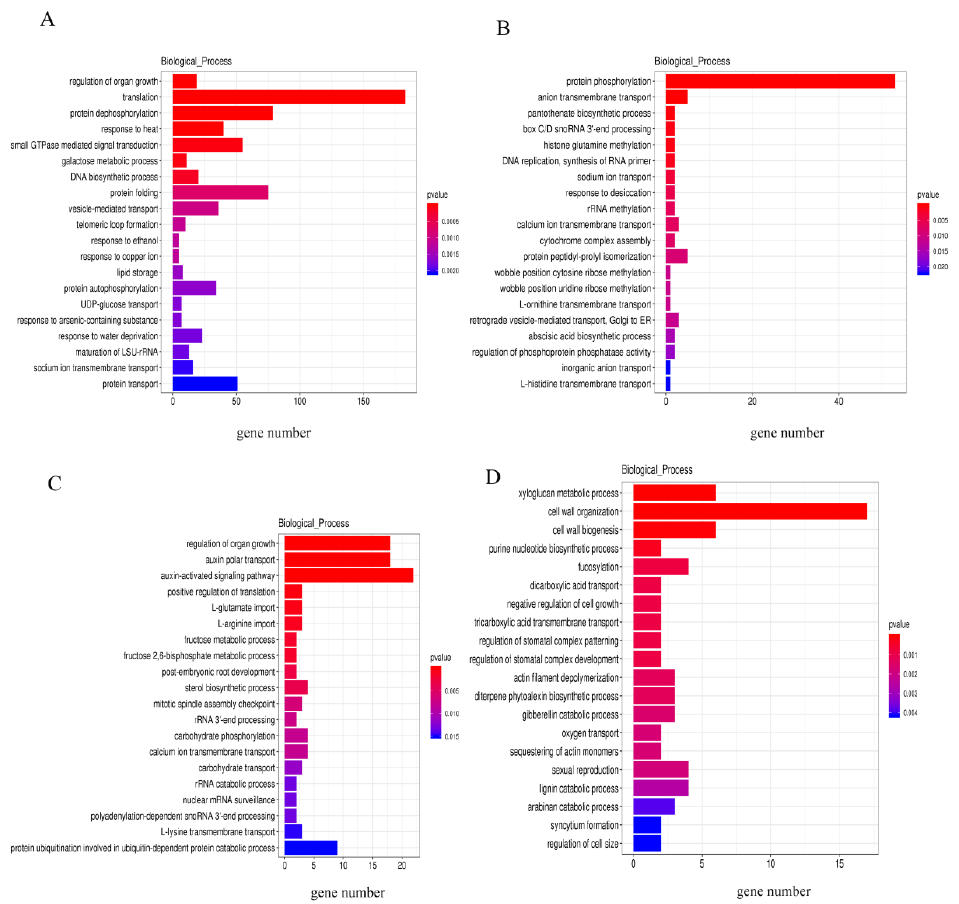
Figure 6. GO enrichment analysis of genes targeted by the DE lncRNAs. ( A ) Biological process terms enriched among target genes of LT-I/0 h DE lncRNAs. ( B ) Biological process terms enriched among target genes of LT-II/LT-I DE lncRNAs. ( C ) Biological process terms enriched among target genes of LT-I/NT-I DE lncRNAs. ( D ) Biological process terms enriched among target genes of LT-II/NT-II DE